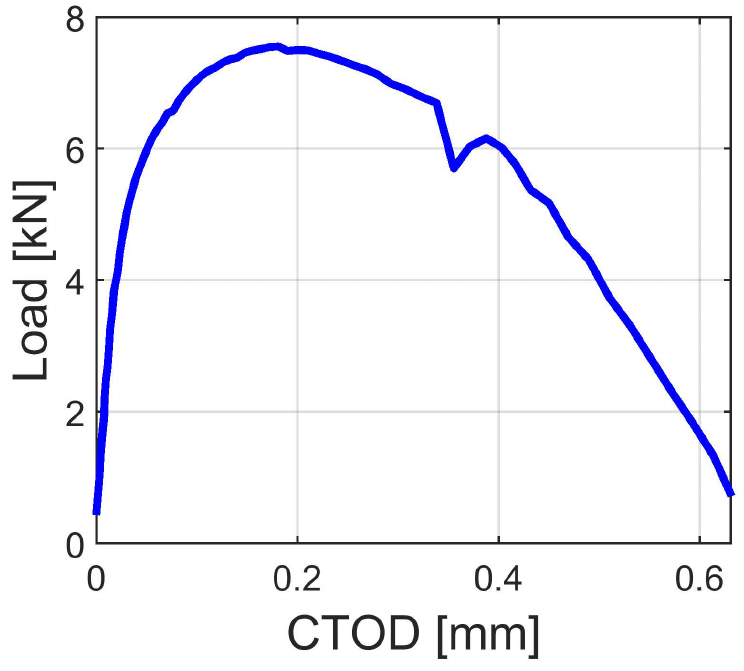
Figure 6. Load versus CTOD from